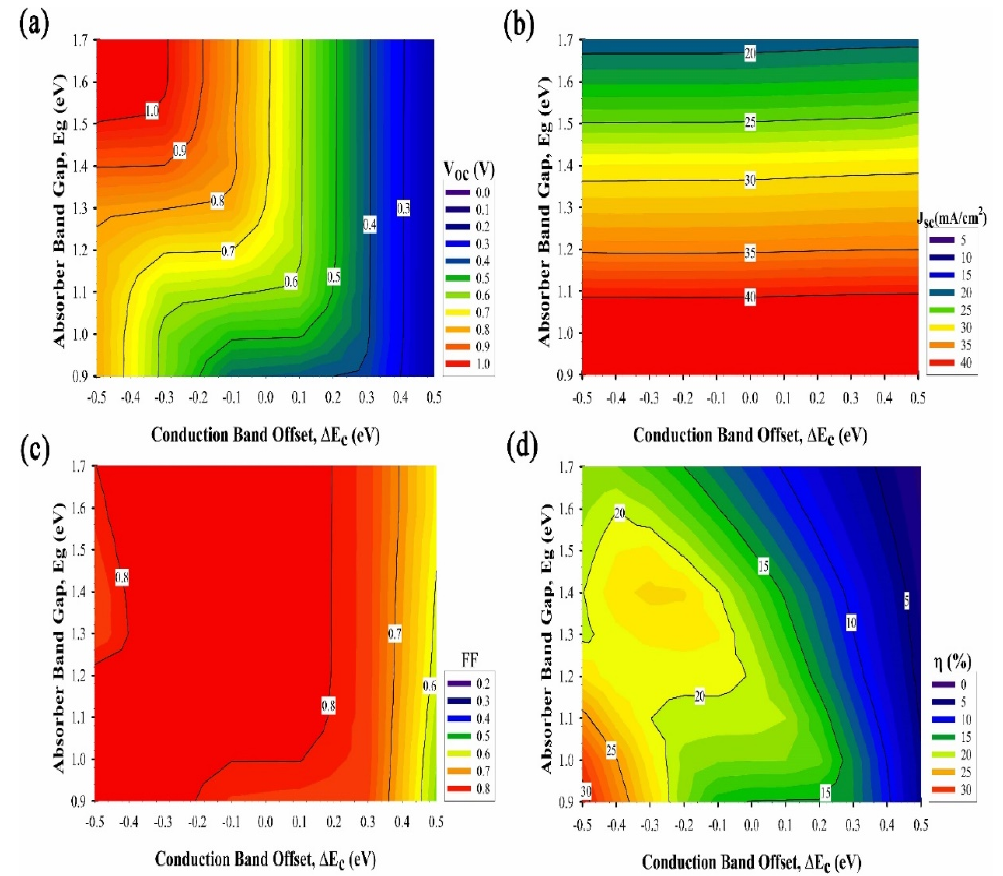
Figure 5. Photovoltaic performance parameters: ( a ) V oc , ( b ) J sc , ( c ) FF and ( d ) efficiency for an ideal p-absorber layer with a CdS buffer layer of Set D (µ: 100 cm 2 /V·s and N D : 10 18 cm −3 ).